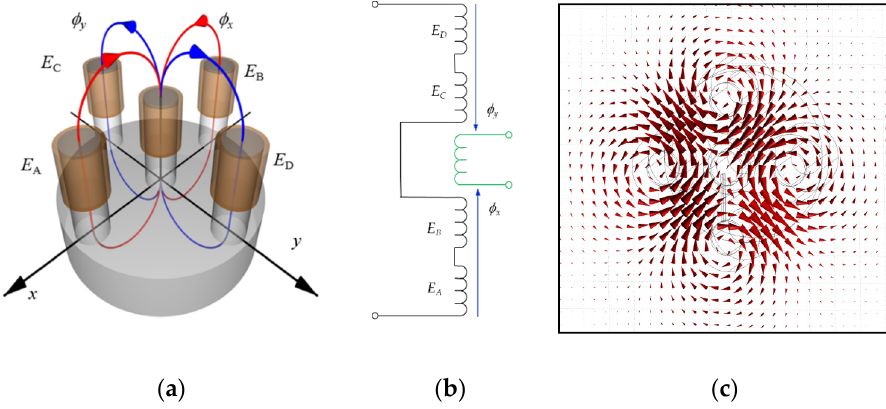
Figure 8. The eddy current transducer: ( a ) the schematic view; ( b ) the electric circuit; ( c ) the distribution of calculated eddy currents induced in the specimen.